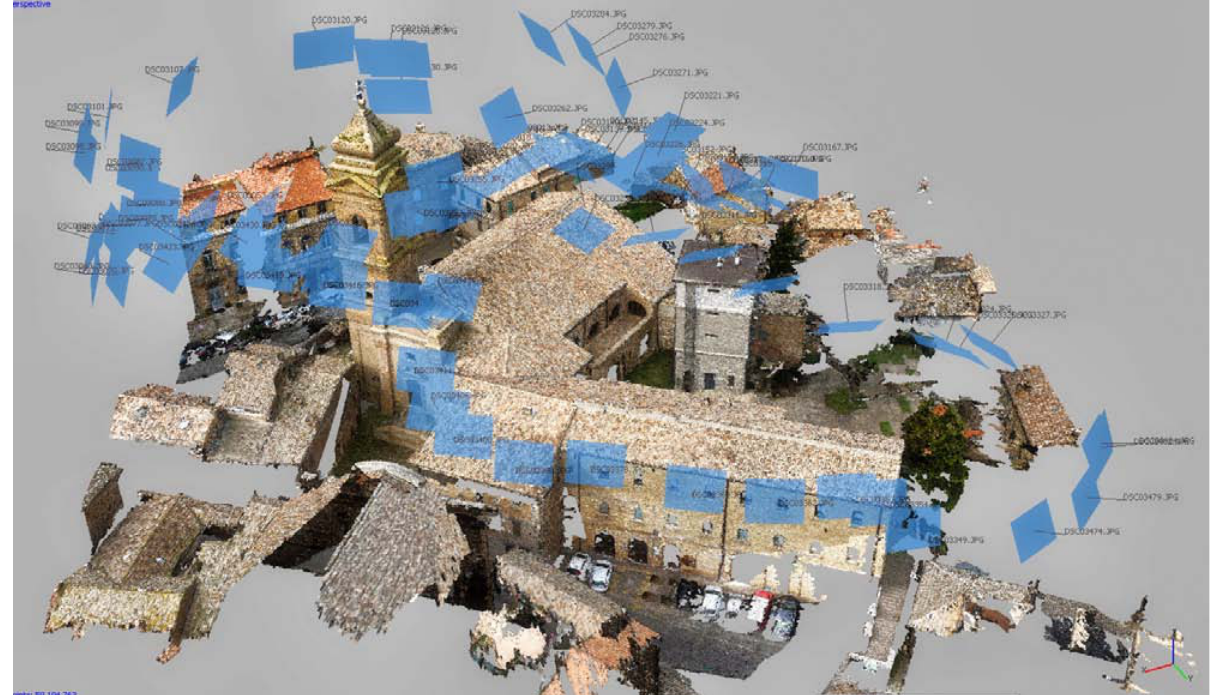
Figure 7. Colored point cloud and marked position of all the pictures taken from the UAV